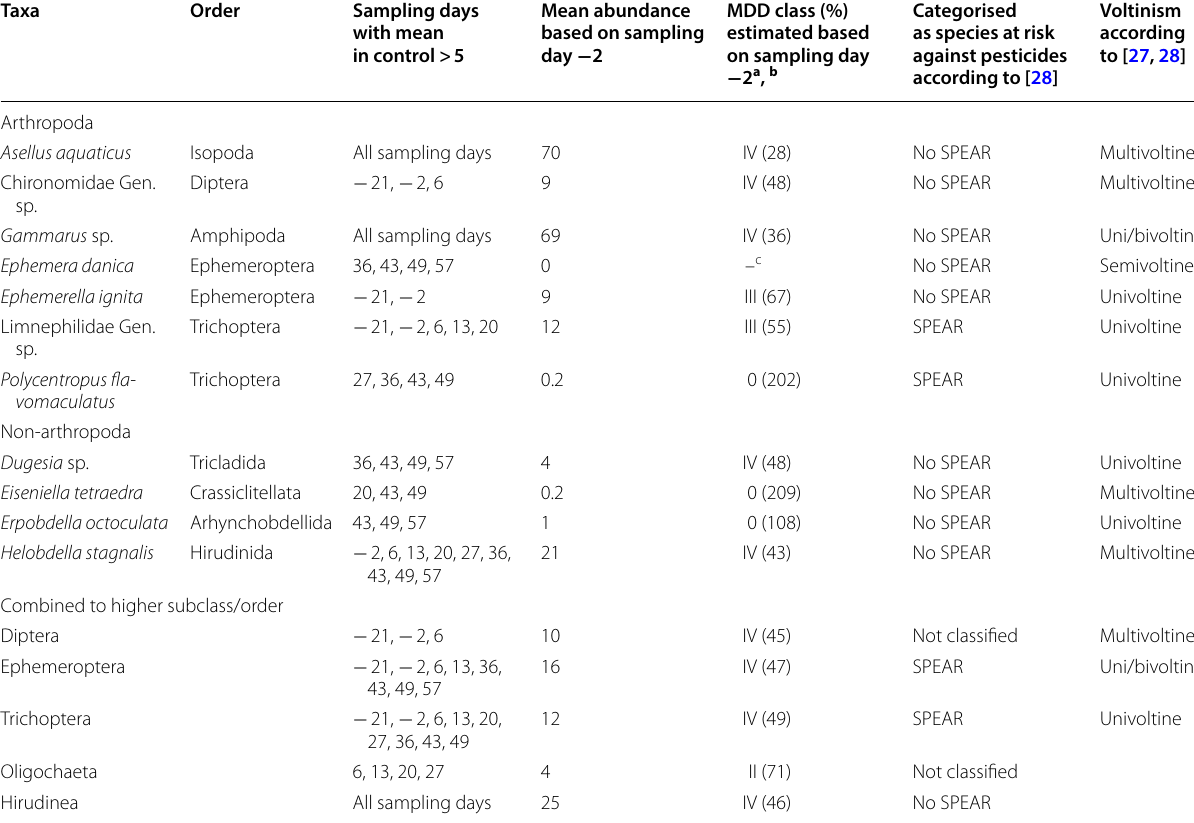
Table 1 Taxa and combined subclasses/orders considered to be sufficiently abundant to assess the effects of the test item on at least two sampling dates (average control abundance > 5)